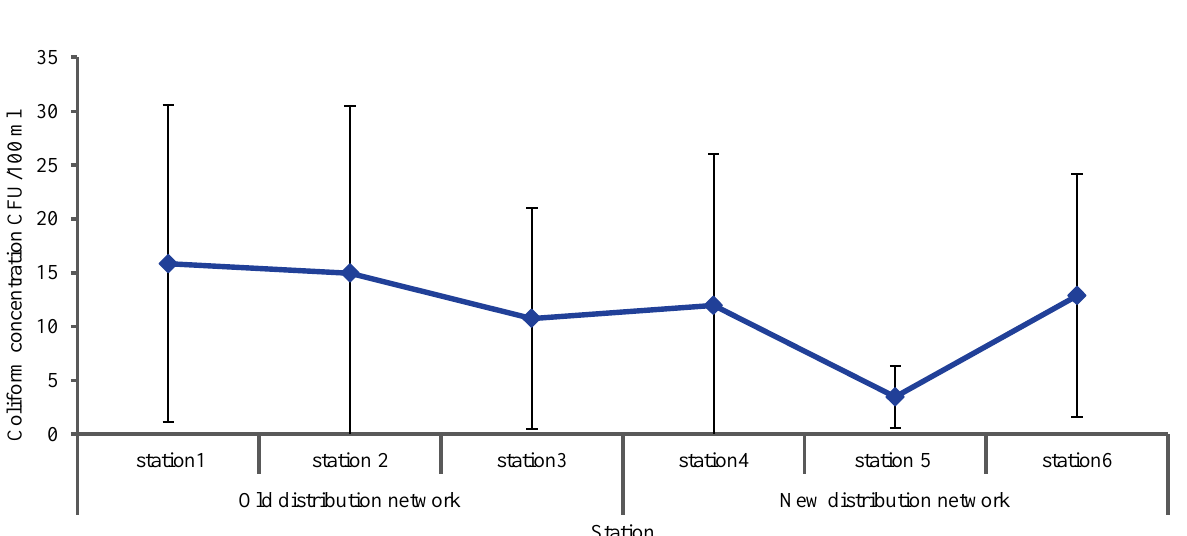
Figure 1. The average and standard deviation of total coliform concentration (CFU/100 ml) in water of the two distribution networks CFU: Colony-forming unit